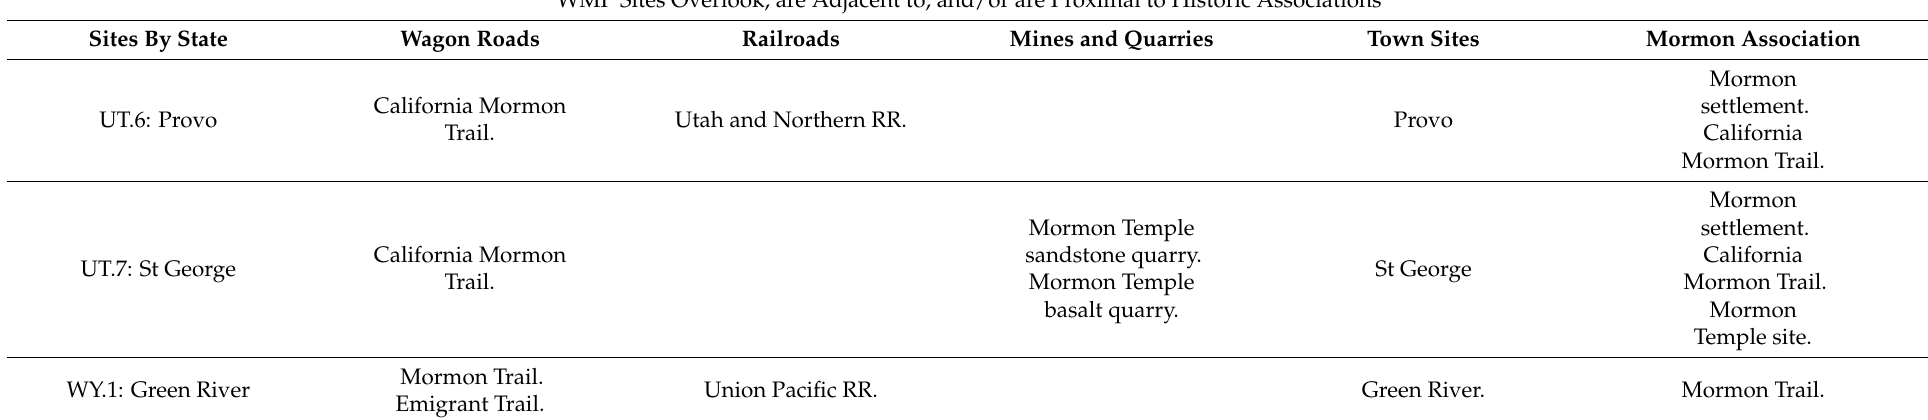
Table A2. Cont. WMP Sites Overlook, are Adjacent to, and/or are Proximal to Historic